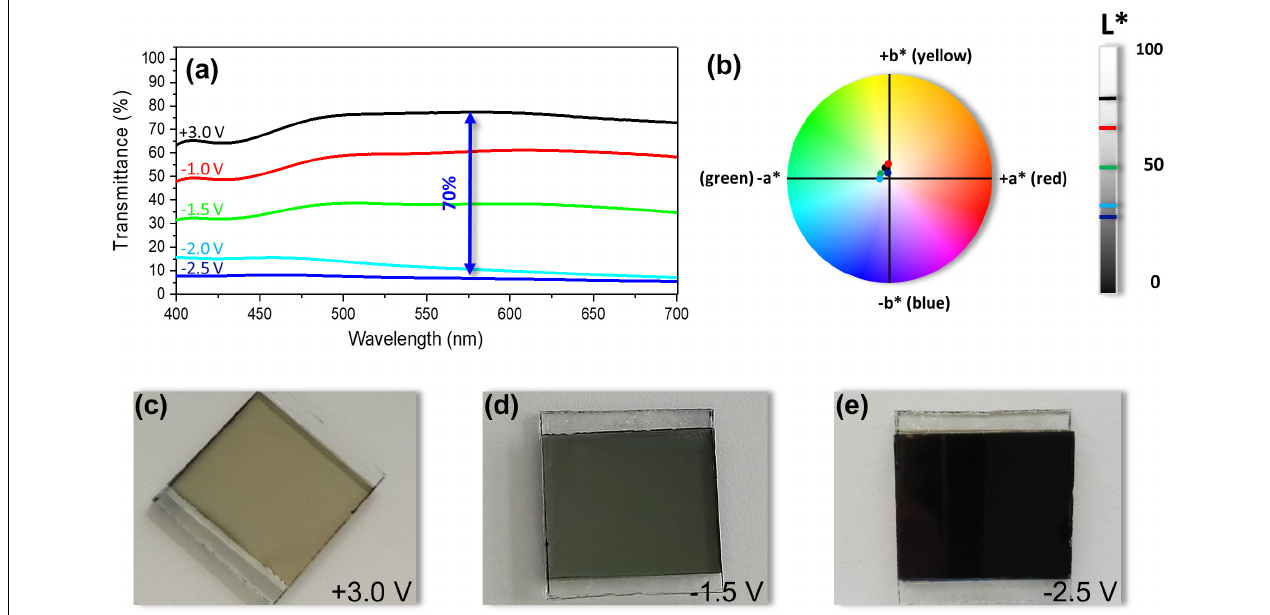
FIGURE 5 | Transmission spectra in the visible region (a) and 1976 CIE L*a*b* color diagram (b) of the glass/ITO/a-WO 3 /d-Ut(600) 10 LiCF 3 SO 3 [Bmim]Cl/c-NiO/ITO/ glass ECD: bleached state [bright mode, +3.0 V, black line, (c) ] and colored states [semi-bright mode (–1.0 V, red line), dark mode [–1.5 V, green line, (d) ], and very dark modes [–2.0 V, cyanide line, and –2.5 V, blue line, (e) ].